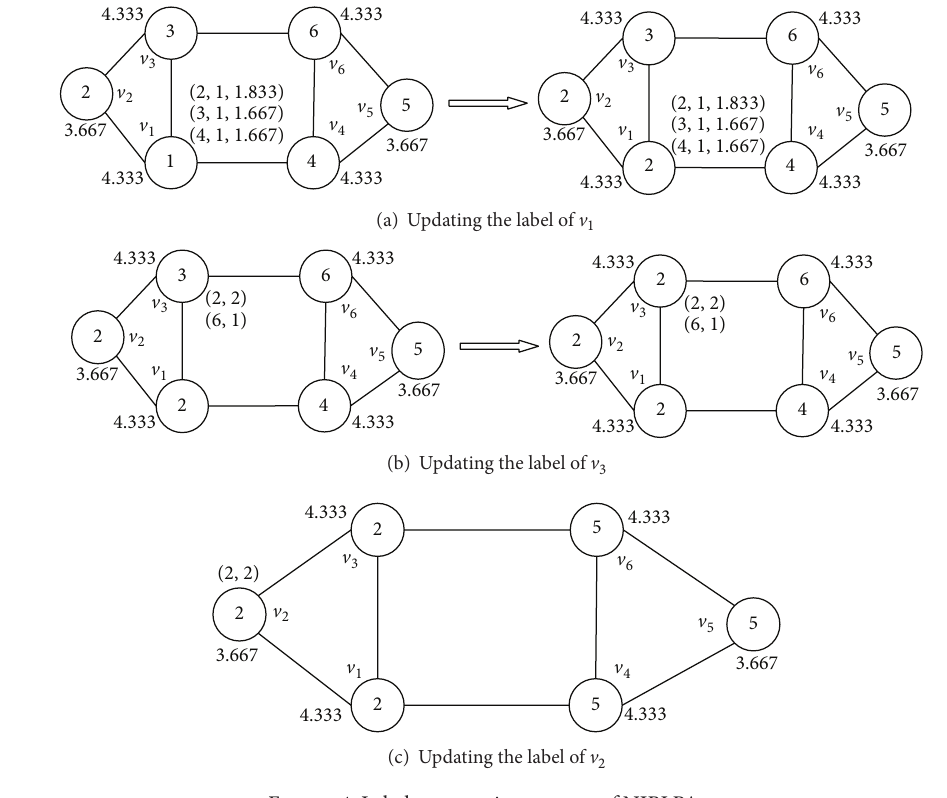
Figure 4: Label propagation process of NIBLPA.